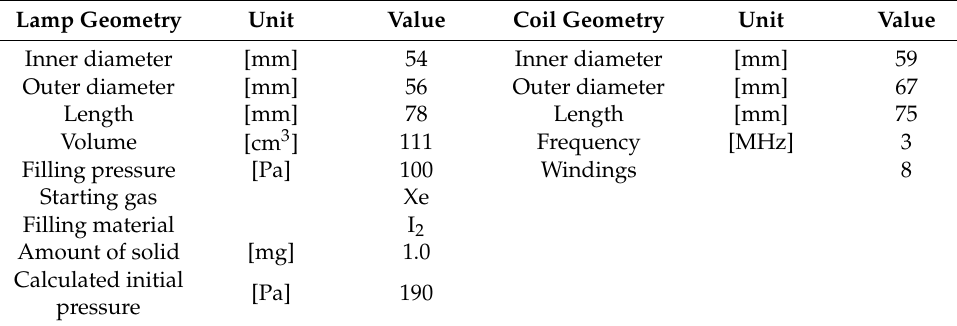
Table 2. Lamp and coil geometry for the I 2